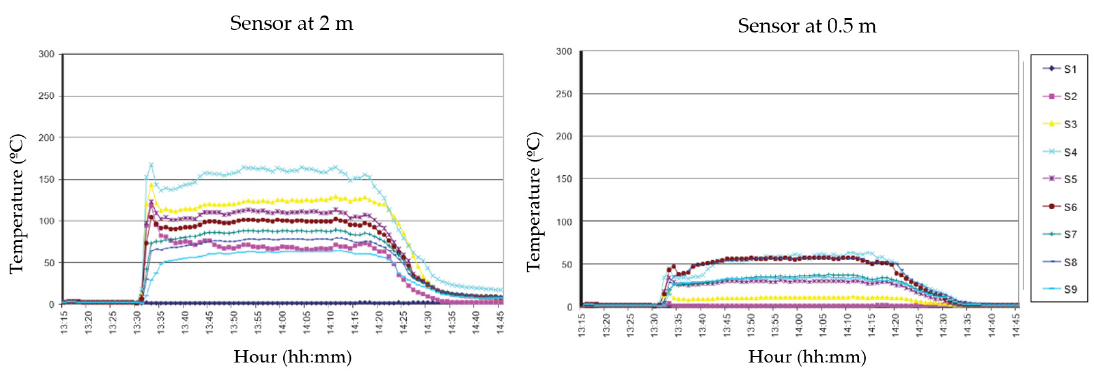
Figure 10. Evolution of the temperature along the drift at different heights; scenario 1.